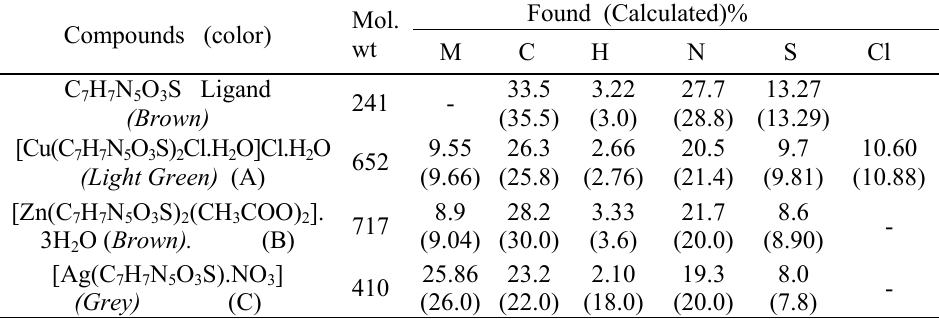
Found (Calculated)%